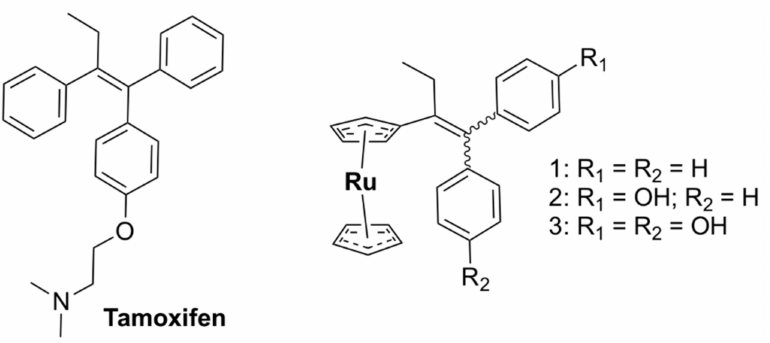
Figure 24. Chemical structures of tamoxifen and the ruthenocenyl complexes incorporating tamoxifen-based